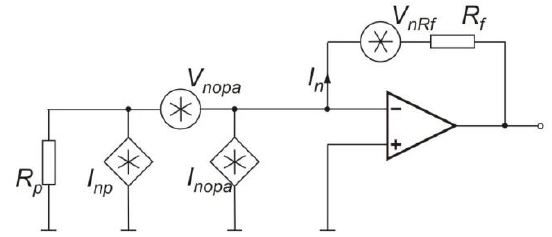
Figure 10. Equivalent scheme of the first stage of the